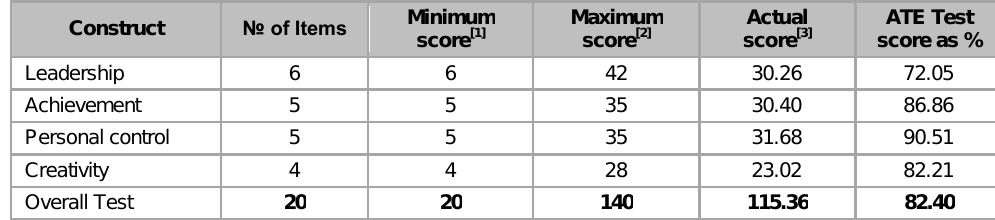
Overall results of the ATE Test in participating schools ( n = 1